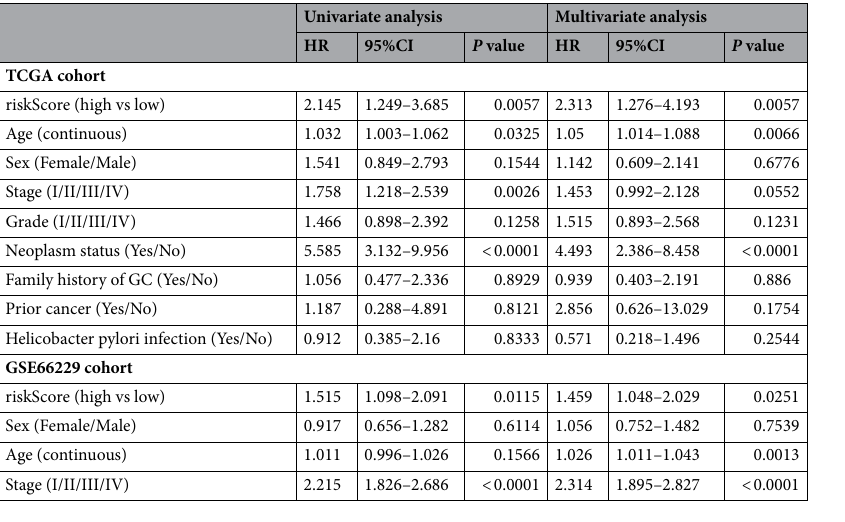
Table 2. Univariate and multivariate analyses identified independent prognostic factors for overall survival of patients with GC in the TCGA cohort and GSE66229